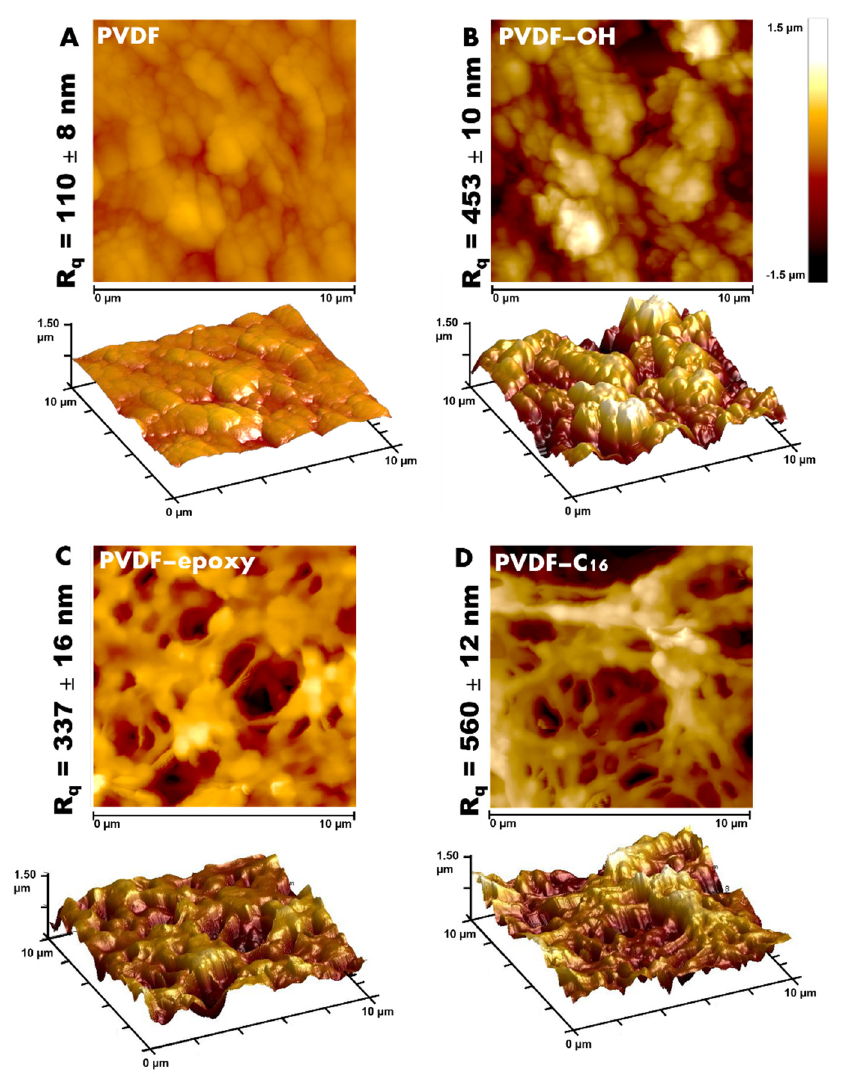
Figure 3. AFM—2D and 3D images of evaluated membranes, pristine PVDF ( A ), activated ( B ), with epoxy modifier ( C ), and C16 modifier ( D ).